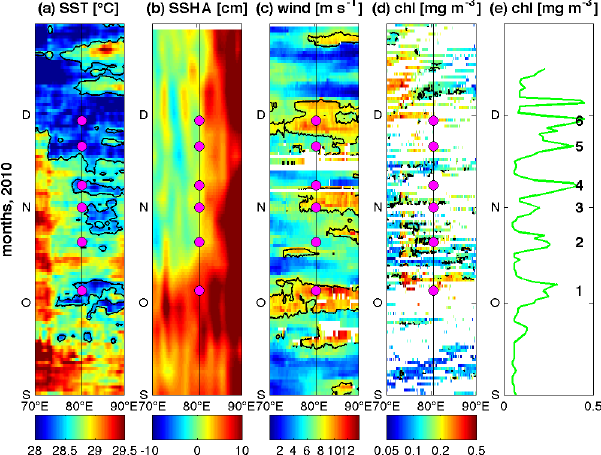
Figure 4. Cross-correlation analyses of physical parameters and chlorophyll from the RAMA mooring at 0 ◦ , 80.5 ◦ E. In the figure legends, the first-named parameter leads the second-named, so, for example, the strong positive peak in wind speed and Chl in panel (b) means that stronger winds are followed by increased chlorophyll about 2–3 days later. The cross-correlation analysis was performed for the section of the data set where the chlorophyll spikes were most obvious: 15 September to 15 December 2010. The shaded re- gion in each panel indicates the 95% confidence interval.